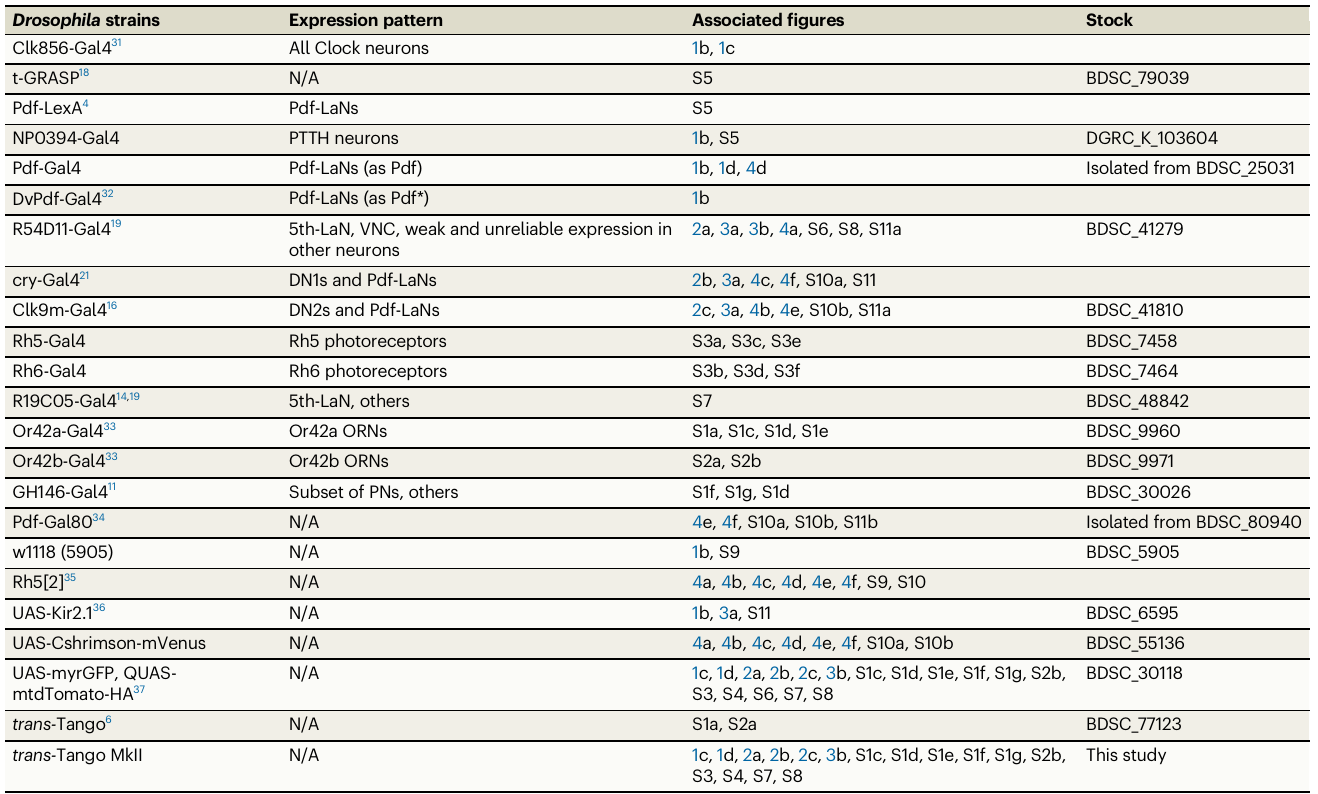
Table 1 | Fly lines used in this study Drosophila